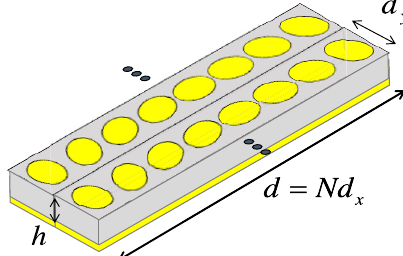
Fig. 4. Geometry for the periodically modulated patch-type MTS.